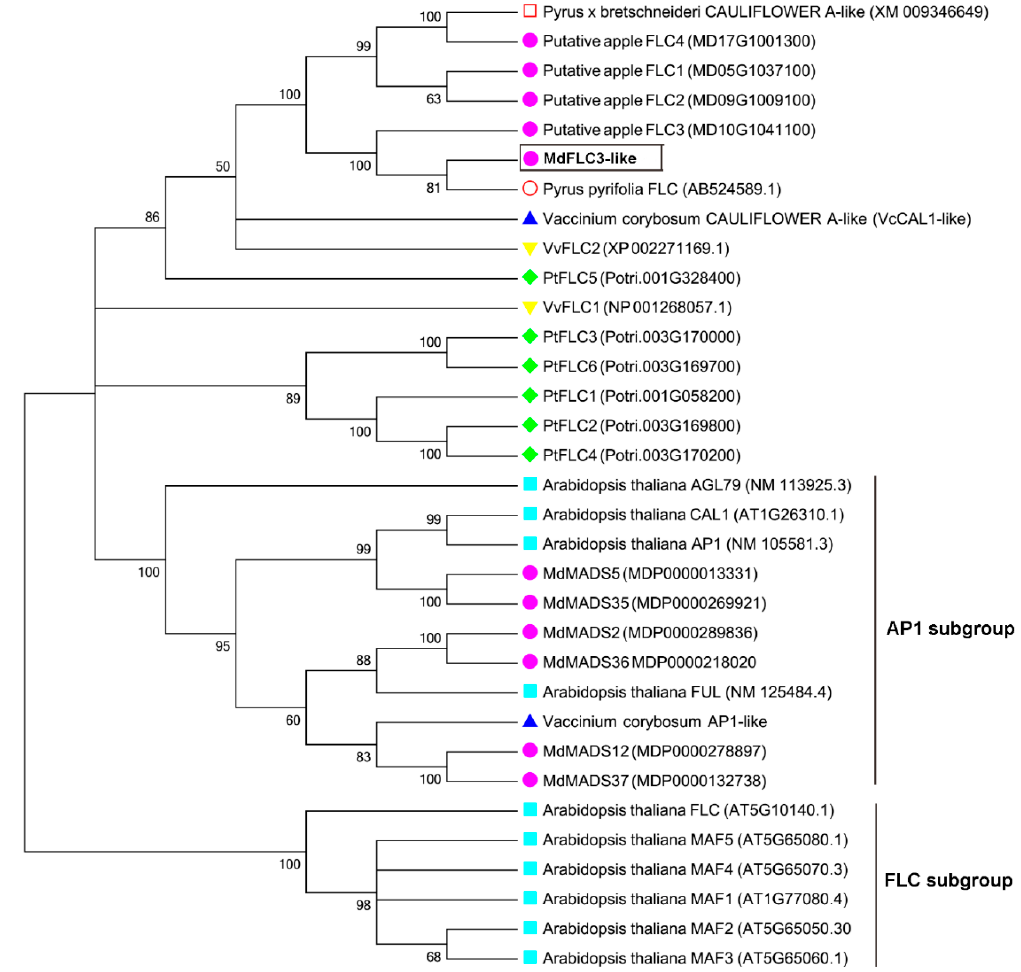
Figure 2. Phylogenetic analysis of FLC-like proteins of woody plants and Arabidopsis FLC and APETALA1 (AP1) proteins. A phylogenetic tree of these MADS-box genes was generated by the neighbor-joining (NJ) method with 1000 bootstrap replicates. The proteins were clustered and divided into two distinct clades, FLC and AP1 .